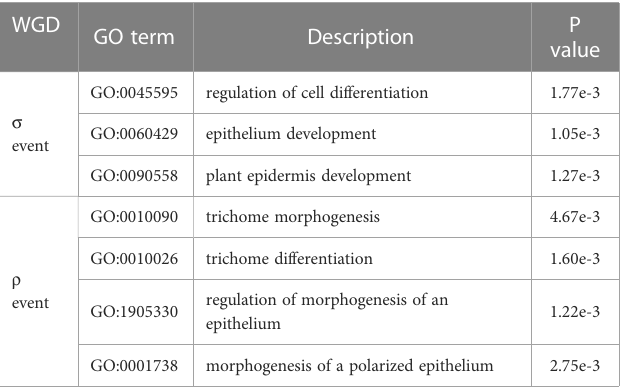
TABLE 5 GO enrichment analysis result of the genes retained after two WGDs in Melastoma candidum